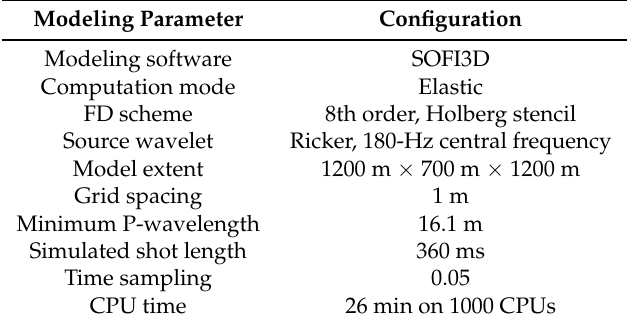
Table 3. Summary of technical parameters used for the seismic forward modeling experiment. FD,